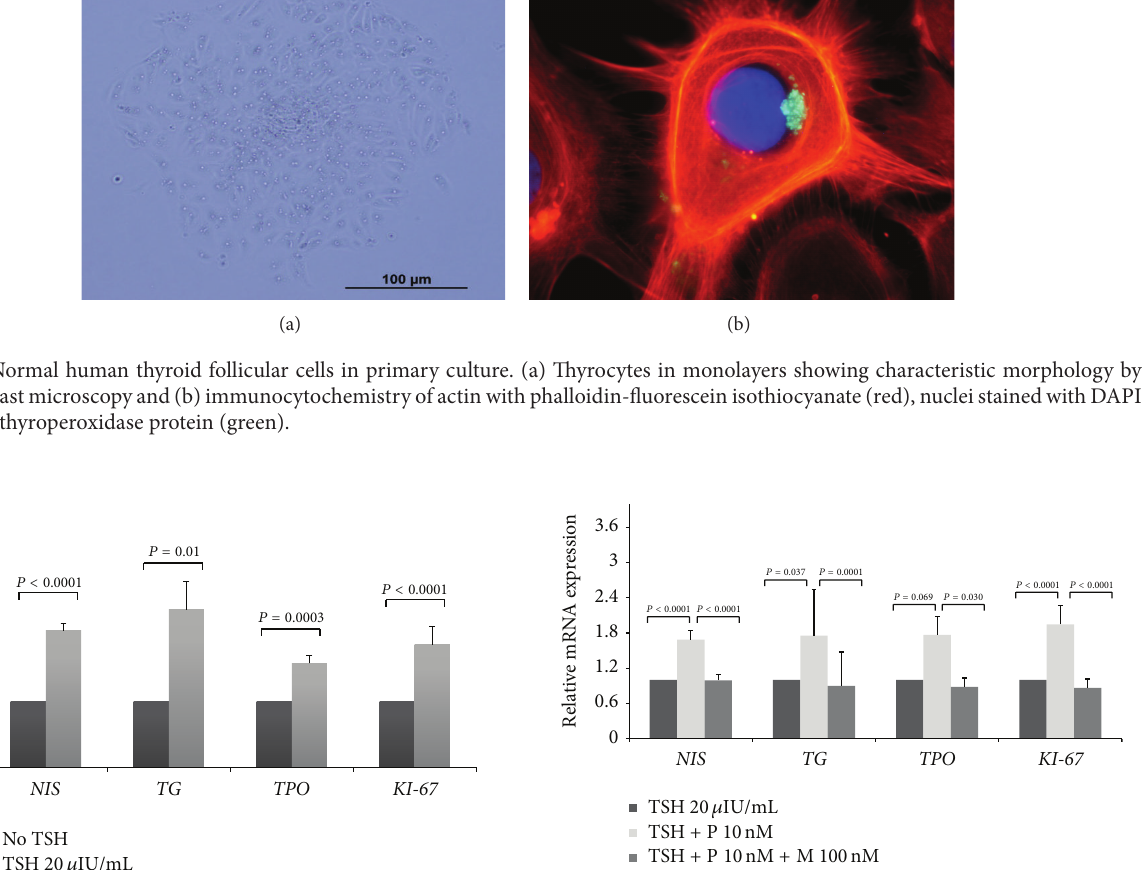
Figure 2: TSH increased mean mRNA expression of human normal thyroid follicular cells genes in primary culture. The sodium-iodide symporter NIS gene was evaluated after 4h, and the thyroglobulin TG , thyroperoxidase TPO , and KI-67 genes were evaluated after 48 h. Data were obtained by RT-qPCR and normalized with 𝛽 -actin gene expression and are shown as the mean ratio of TSH/no TSH ± standard deviation, considering no TSH = 1. The experiments were performed in duplicate and repeated in three independent cultures for NIS and four independent cultures for TG , TPO , and KI-67 .